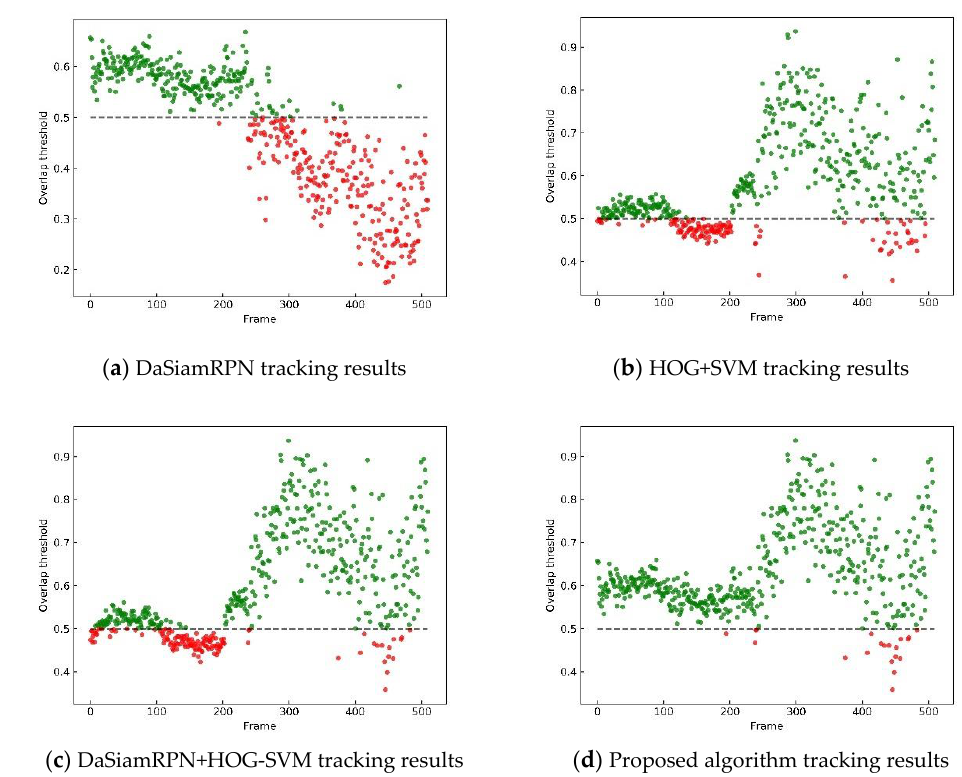
Figure 9. The overlap precision scatter diagram of Video Sequence I with four different trackers.